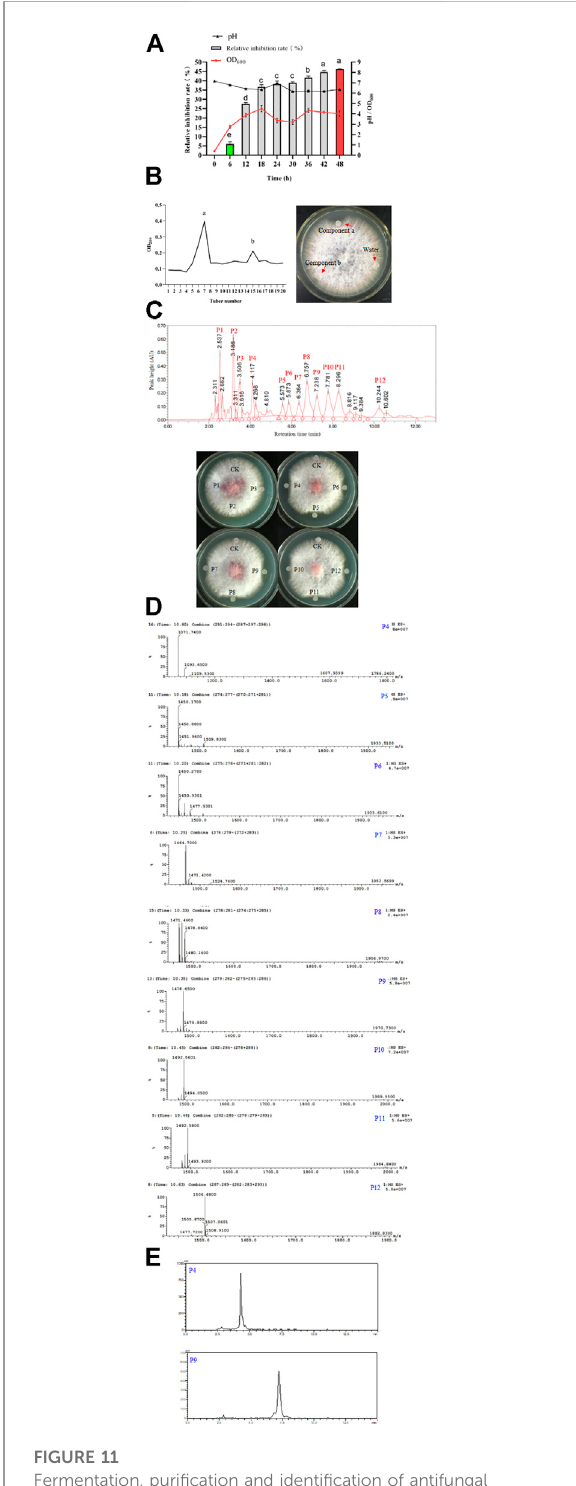
FIGURE 11 (Continued) lipopeptidesbyRP-HPLC.Top:P1 – P12werethepeakswitha retentiontime 2.537, 3.186,3.506, 4.117, 5.573,5.873, 6.364,6.757, 7.238, 7.781, 8.296 and 10.244 min, respectively; Bottom: ( Continued )